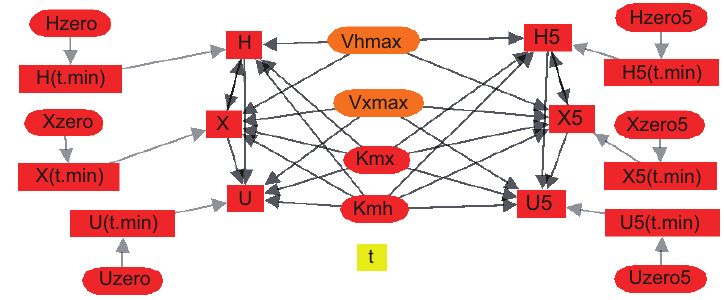
Figure 5. Connectivity graph for a modified version of the model program in Box 1. For Hx → Xa → Ua, the oxidation of hypoxanthine to xanthine to uric acid, catalyzed by xanthine oxidase. The connectivity is shown for a dual solution version of the code for fitting two different sets of experimental data simultaneously with a common group of parameters so as to obtain a minimally biased set of parameter confidence